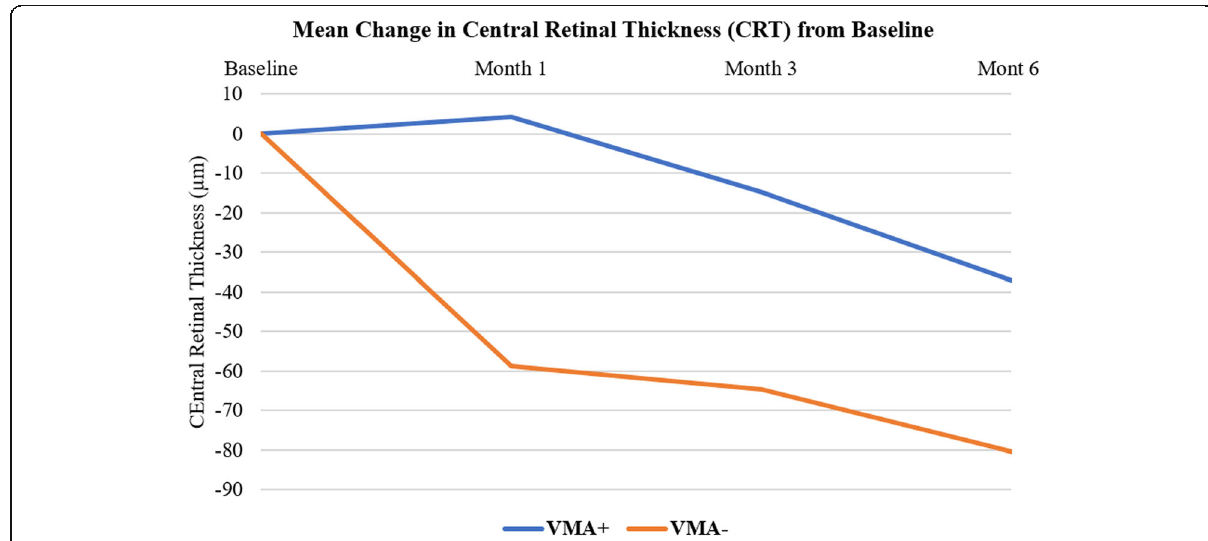
Fig. 2 Mean change in central retinal thickness. The mean change in central retinal thickness (CRT) from baseline at different study intervals for the 2 study groups. VMA+, vitreomacular adhesion present; VMA − , vitreomacular adhesion